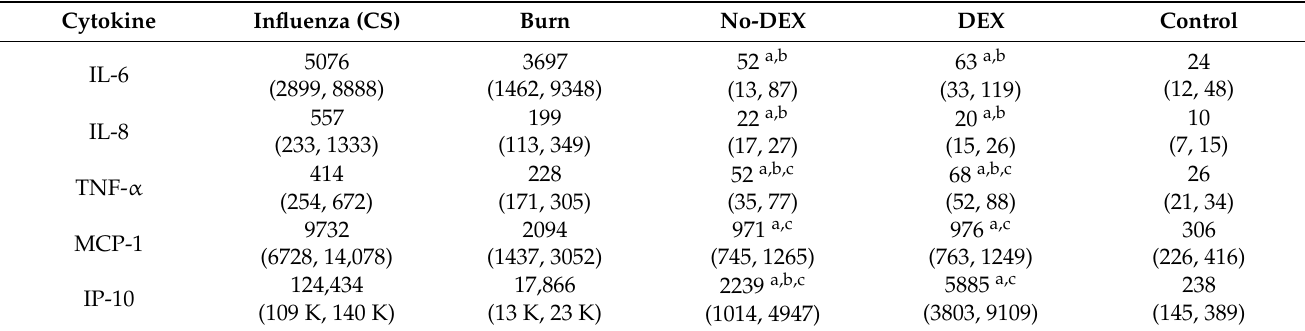
Geometric means of concentrations are shown in pg/mL with lower and upper 95% confidence limits in parenthesis. None of the cytokine concentrations were statistically different between the DEX and no-DEX groups ( p > 0.01). N values are 17, 19, 9, 6 and 26 for the no-DEX, DEX, influenza (CS), burn and control groups, respectively. K represents ×1000. a p < 0.01 compared to influenza (CS) group. b p < 0.01 compared to burn group. c p < 0.01 compared to control group.